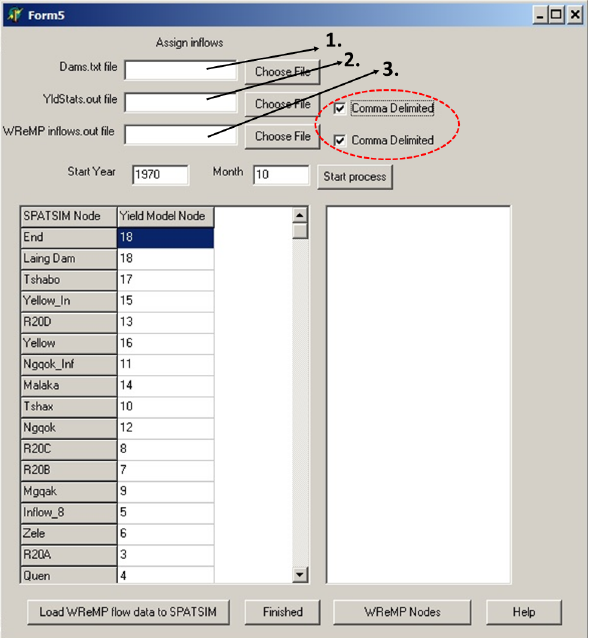
Figure 2. User interface of the Water Quality Systems Assessment Model (WQSAM) (Slaughter et al., 2012) for reading in flow out- puts of the systems